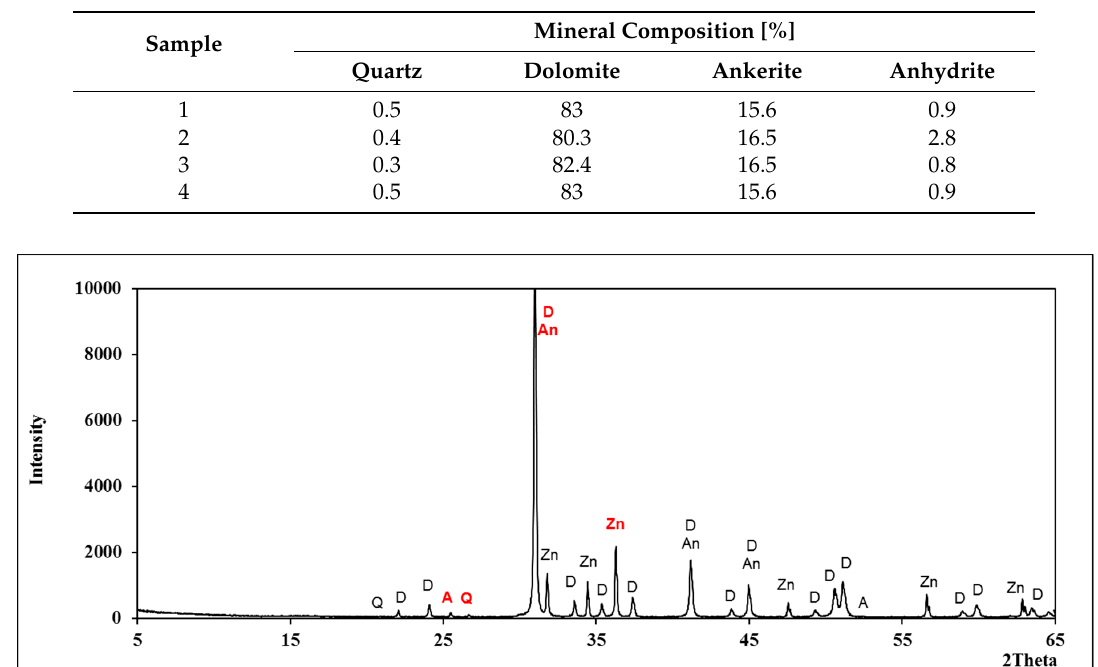
Figure 1. Exemplary diffractogram of sample 1.